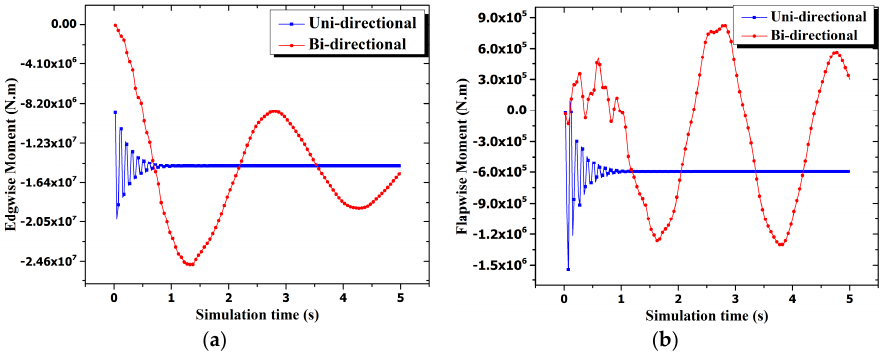
Figure 18. ( a ) Edgewise moment; and ( b ) Flapwise moment variation with time at rated speed.